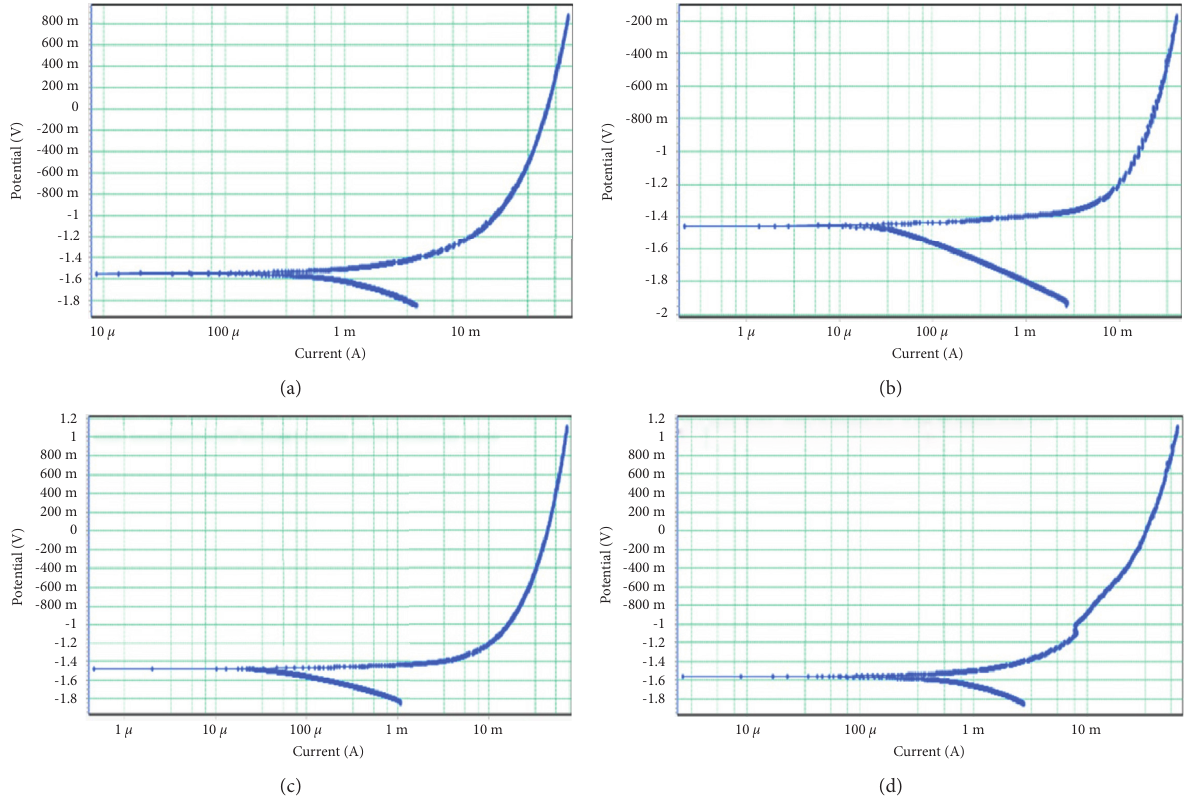
Figure 11: Potentio dynamic polarization results samples. (a) AZ91D +0.0wt.%Li+0.0wt.%Ce (b) AZ91D+0.5wt.%Li+0.5wt.%Ce (c) AZ91D +1.0wt.%Li+1.0wt.%Ce (d) AZ91D+ 2.0wt.%Li+